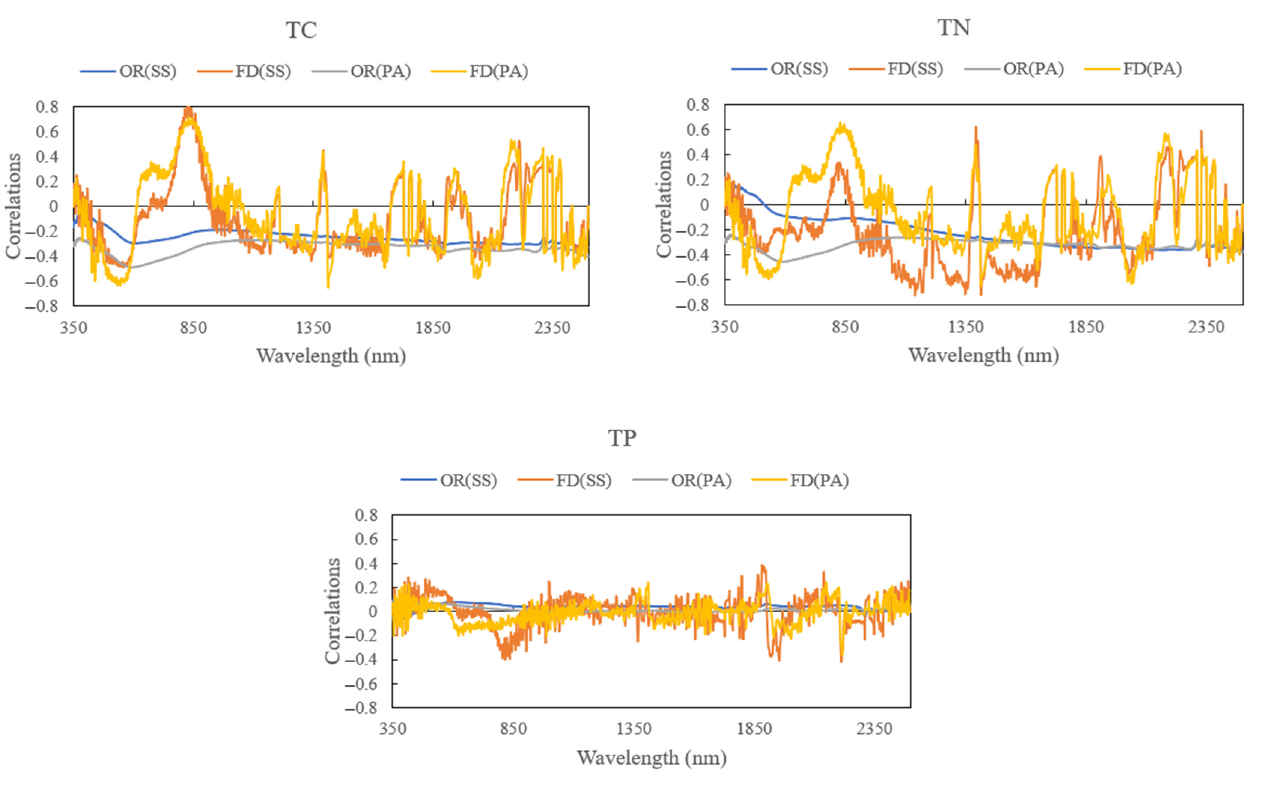
Figure 4. Correlation between the original reflectance (OR) and first derivative reflectance (FD) of P. australis (PA) and S. salsa (SS) and the soil total carbon (TC), total nitrogen (TN), and total phosphorus (TP)